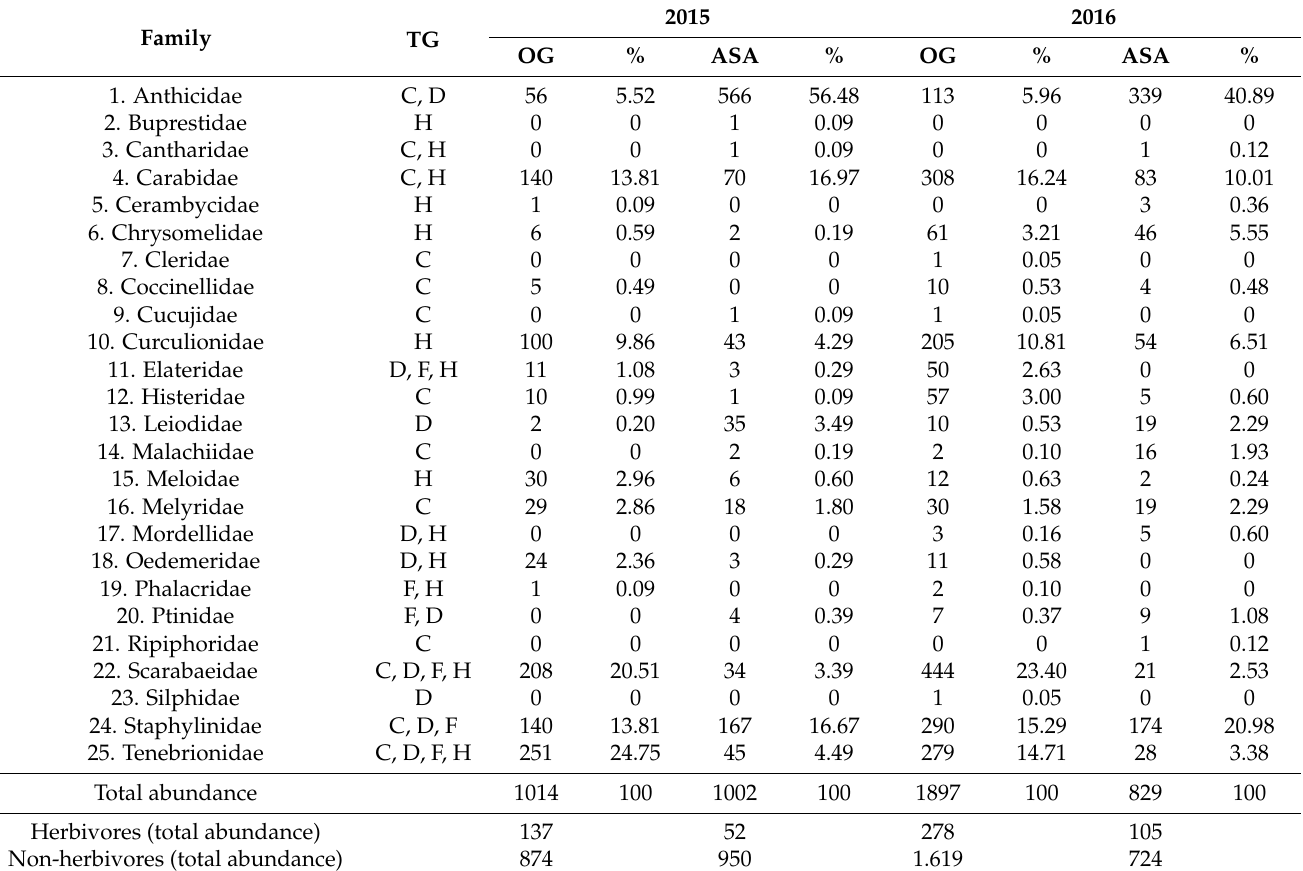
Table 1. Abundance and Frequency (%) of Beetles Captured in Olive Groves (OG) and Adjacent Shrubland Areas (ASA) in the Mirandela Region (Northeast Portugal) in 2015 and 2016. TG Stands for Trophic Groups (H: Herbivores; C: Carnivores; F: Fungivores; D: Detritivores).